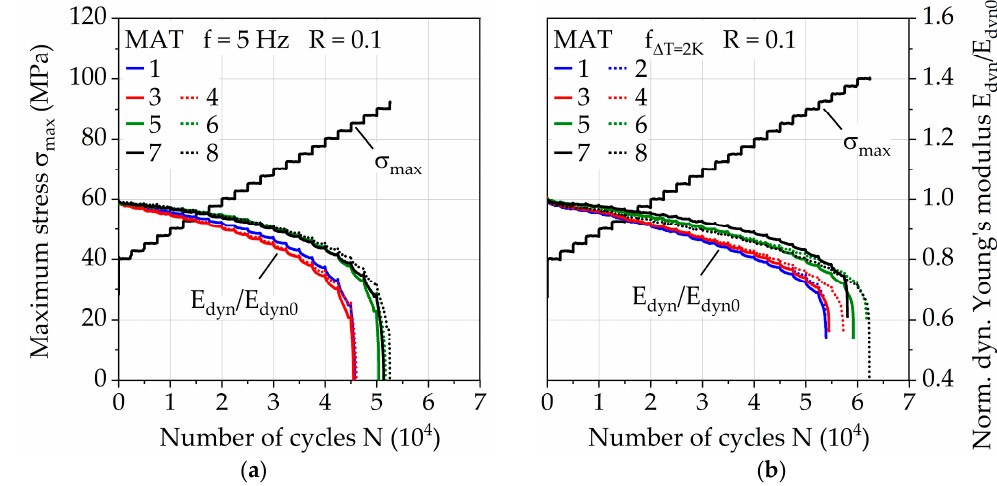
Figure 10. Normalized dynamic Young’s modulus in multiple amplitude tests with ( a ) constant testing frequency of 5 Hz